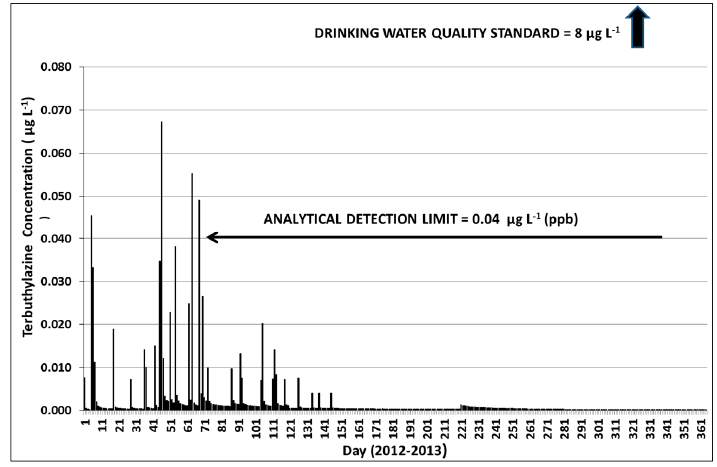
Figure 13. Year 1—modeled daily average concentrations of terbuthylazine in the Rangitaiki River at the Rangitaiki flow gauge.